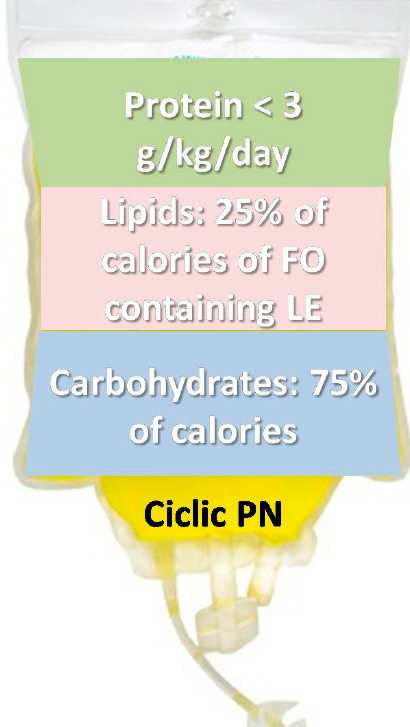
Figure 2. Suggestion of long-term parenteral nutrition preparation for children above 6 months of age. FO: fish oil, LE: lipid emulsion, PN: parenteral nutrition.